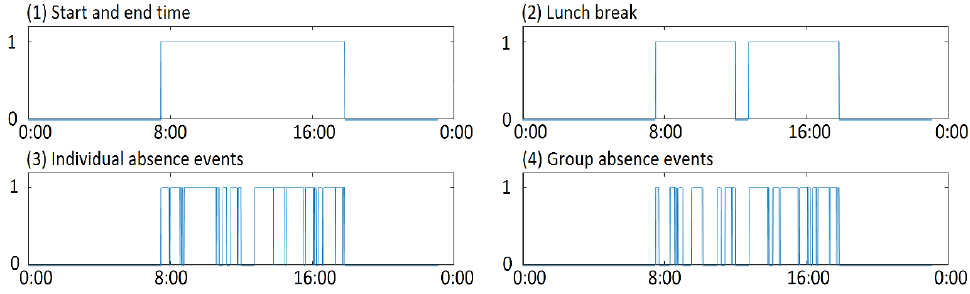
Figure 2. Stepwise individual occupancy generation.